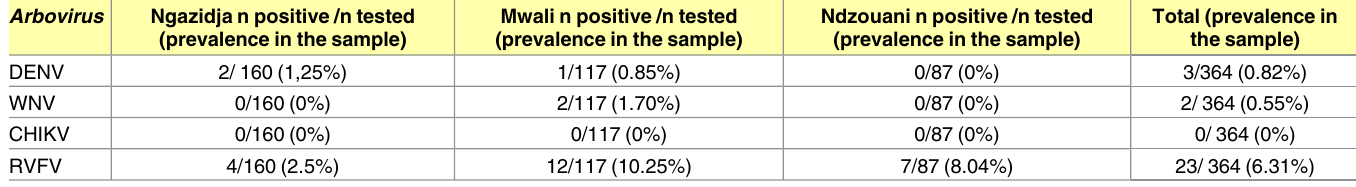
Table 3. IgM antibodies to DENV, WNV, CHIKV and RVFV in 364 sera collected from Grande Comore, Moheli and Anjouan. Arbovirus Ngazidja n positive /n tested Mwali n positive /n tested (prevalence in the sample) (prevalence in the